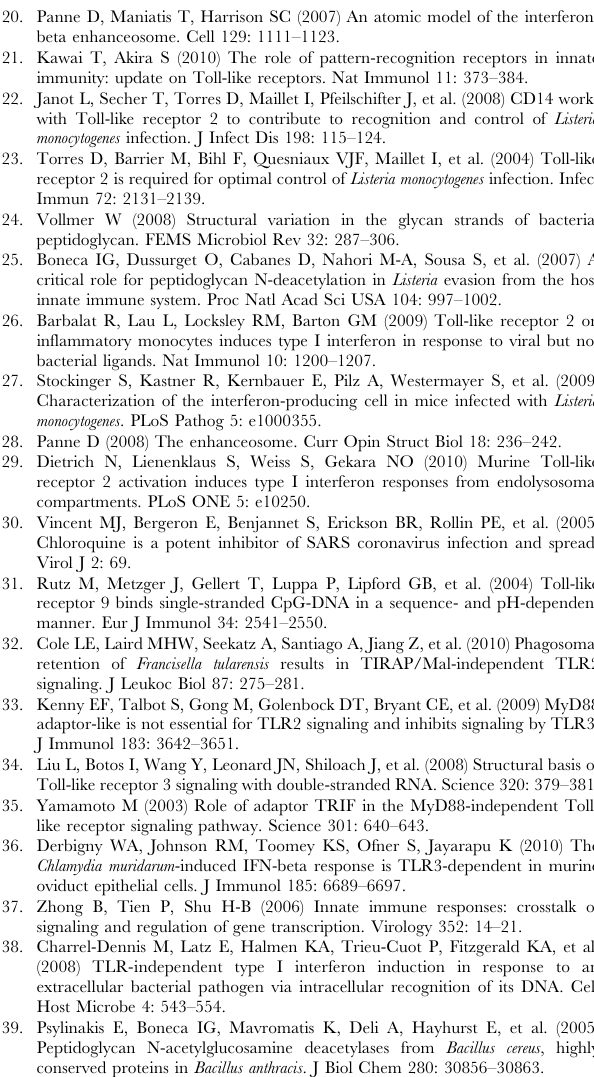
Figure S1 TRIF is not required for IFN- b response to Listeria in bone marrow macrophages. BMM from C57BL/6J or trif 2 / 2 mice were infected with the parental EGDe strain (black bars) or the D pgdA mutant (grey bars). After 4 h of infection, IFN- b induction was measured by qRT-PCR. Data are mean 6 SD (NS, non significant, n =3).